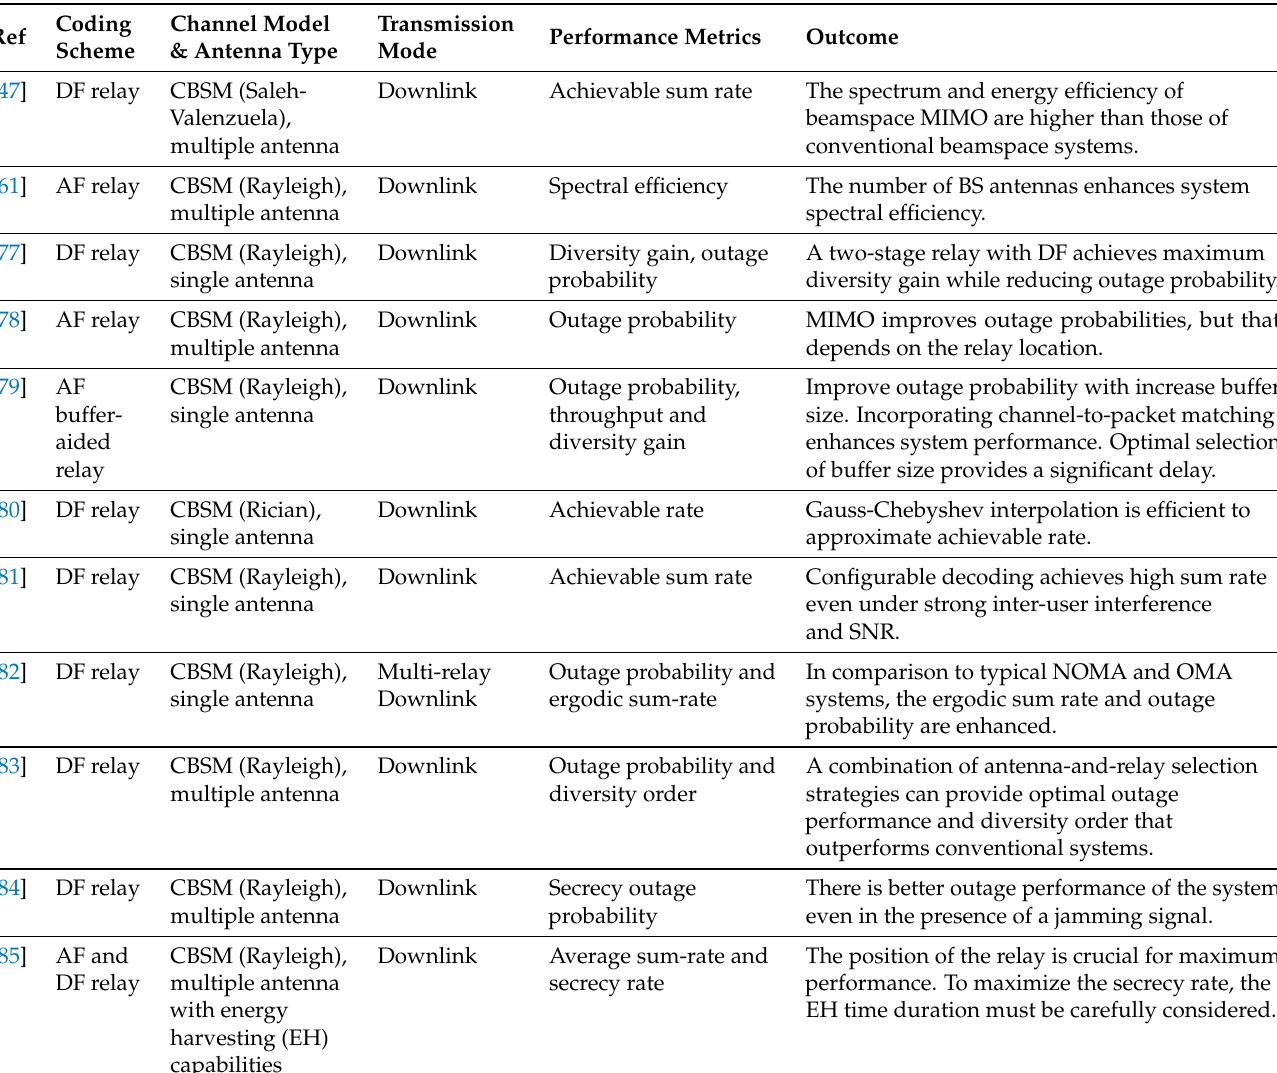
Figure 2. Downlink cooperative relay aided NOMA network with CBSM channel. Table 1. Performance of AF/DF based CR-NOMA with CBSM channel